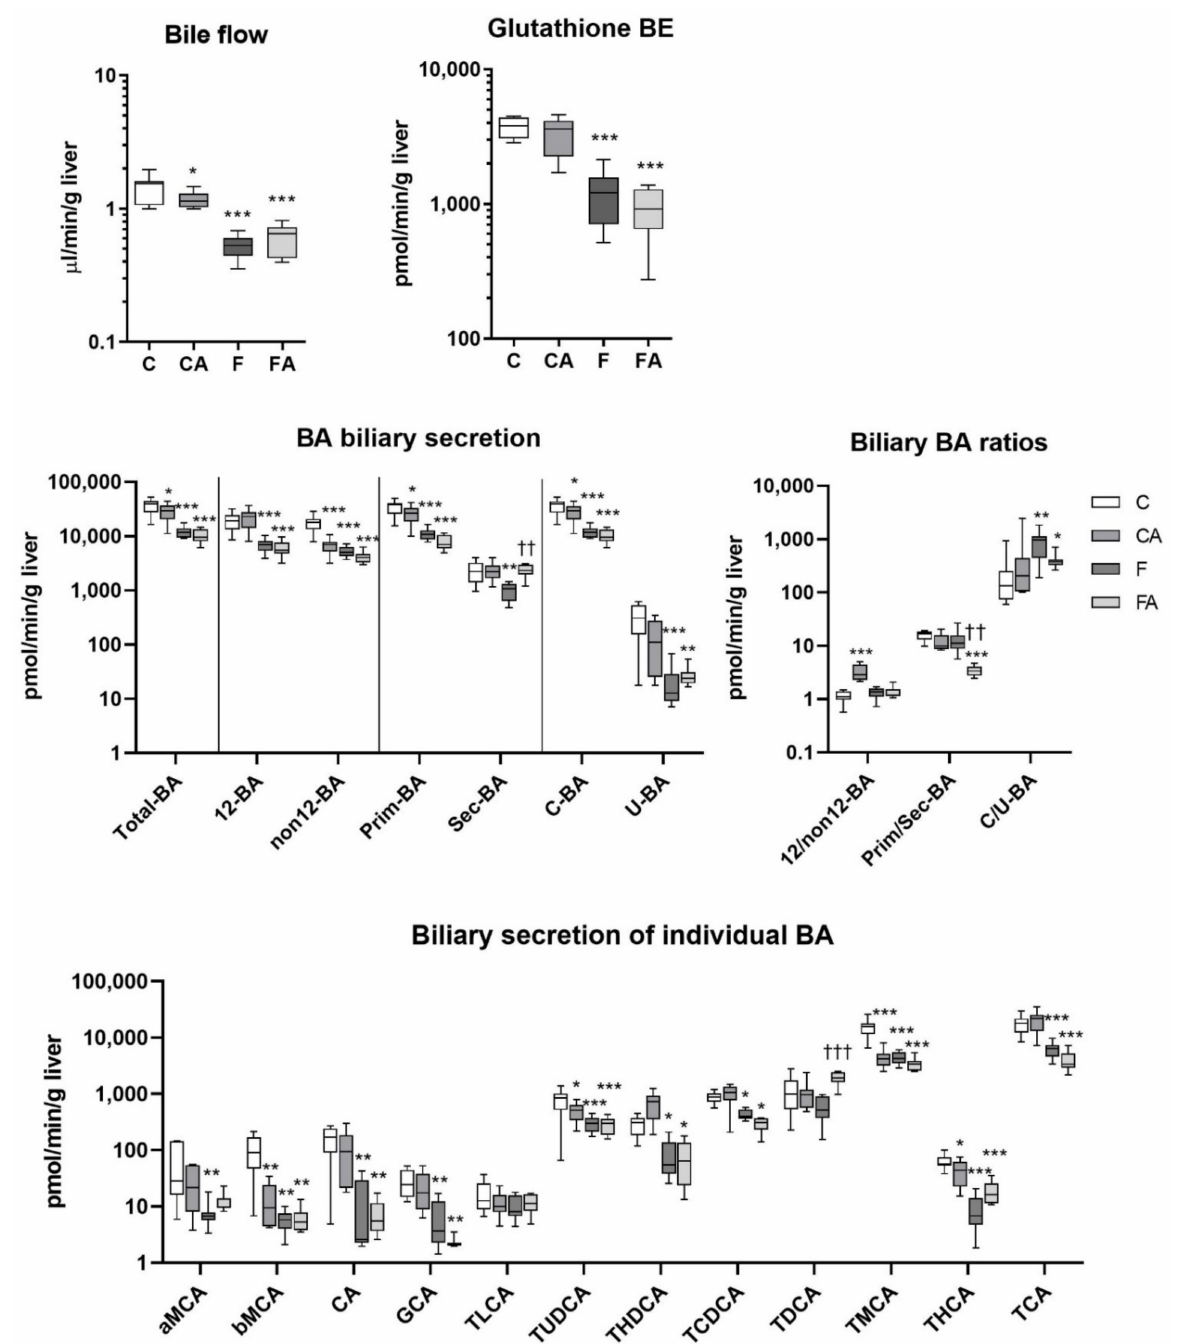
Figure 5. F diet consumption and atorvastatin administration modulated biliary excretion of BA. NASH was induced in mice by 24 weeks of F diet consumption, with atorvastatin (A) administered orally (20 mg/kg/day) during the last three weeks. Corresponding control groups received a chow (C) diet. BA and glutathione were analyzed in bile collected following cannulation of the gallbladder. Data are presented as median values, with boxes and whiskers representing the interquartile range and fifth to 95th percentiles, respectively. * p < 0.01, ** p < 0.01, and *** p < 0.001 atorvastatin and/or F-diet vs. vehicle-administered chow diet–treated mice; †† p < 0.01 and ††† p < 0.001 atorvastatin-treated vs. vehicle-treated NASH mice. BA are presented as follows: 12 α -hydroxylated (12 BA), non12 α -hydroxylated (non12 BA), primary (Prim-BA), secondary (Sec-BA), conjugated (C-BA), unconjugated (U-BA), α / β muricholic acid ( α / β MCA), cholic acid (CA), glycocholic acid (GCA), taurolithocholic acid (TLCA), tauroursodeoxycholic acid (TUDCA), taurohyodeoxycholic acid (THDCA), taurochenodeoxycholic acid (TCDCA), taurodeoxycholic acid (TDCA), tauromuricholic acid (TMCA), taurohyocholic acid (THCA), and taurocholic acid